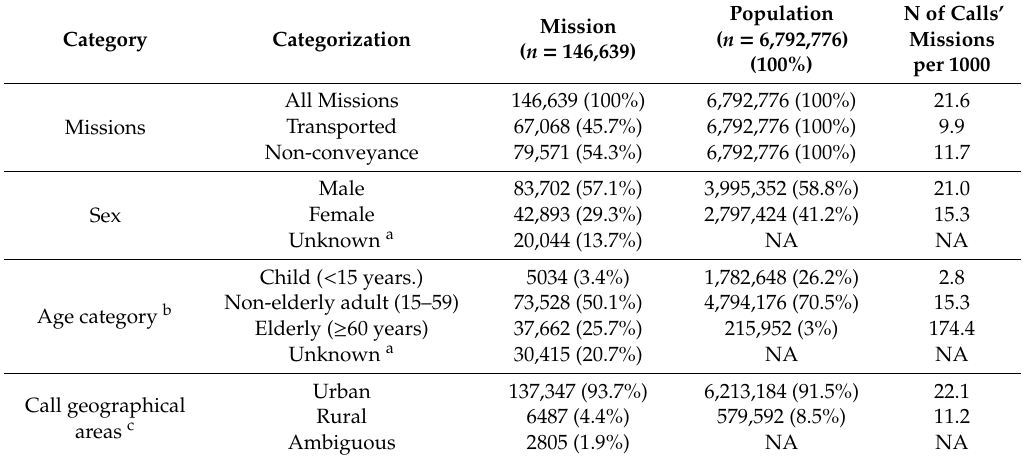
Table 2. Description of the Total Missions Dispatched by Sex, Age category and Geographical Area.